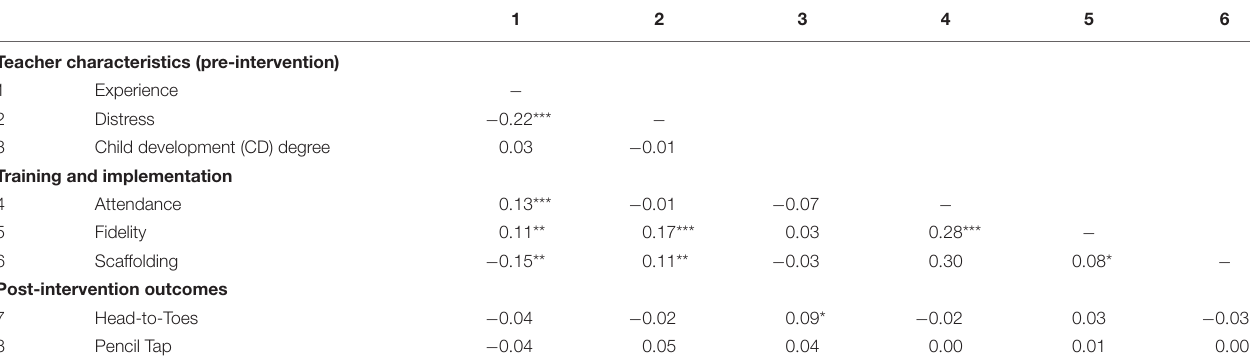
TABLE 3 | Correlations between and among teacher characteristics, tools implementation, and children’s executive function